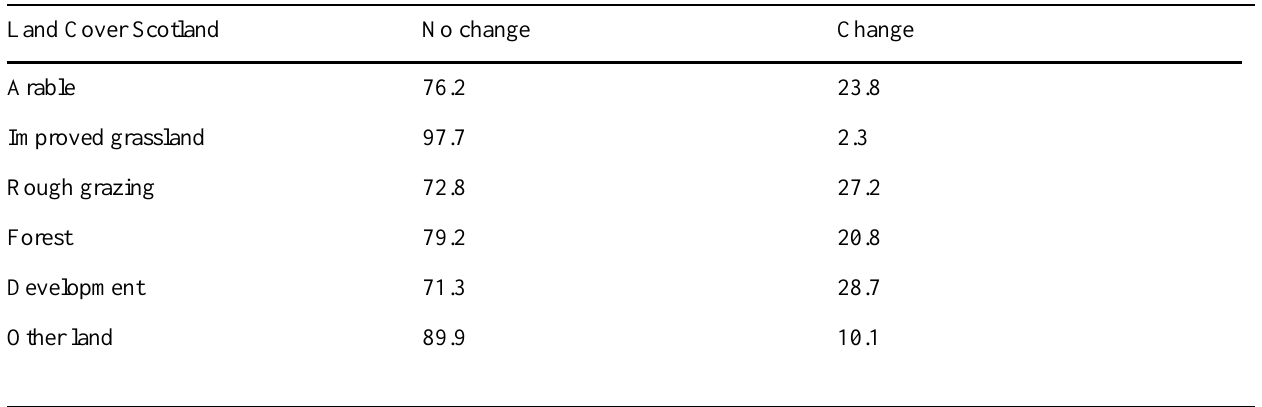
Table 3. Conditional probabilities for land-cover